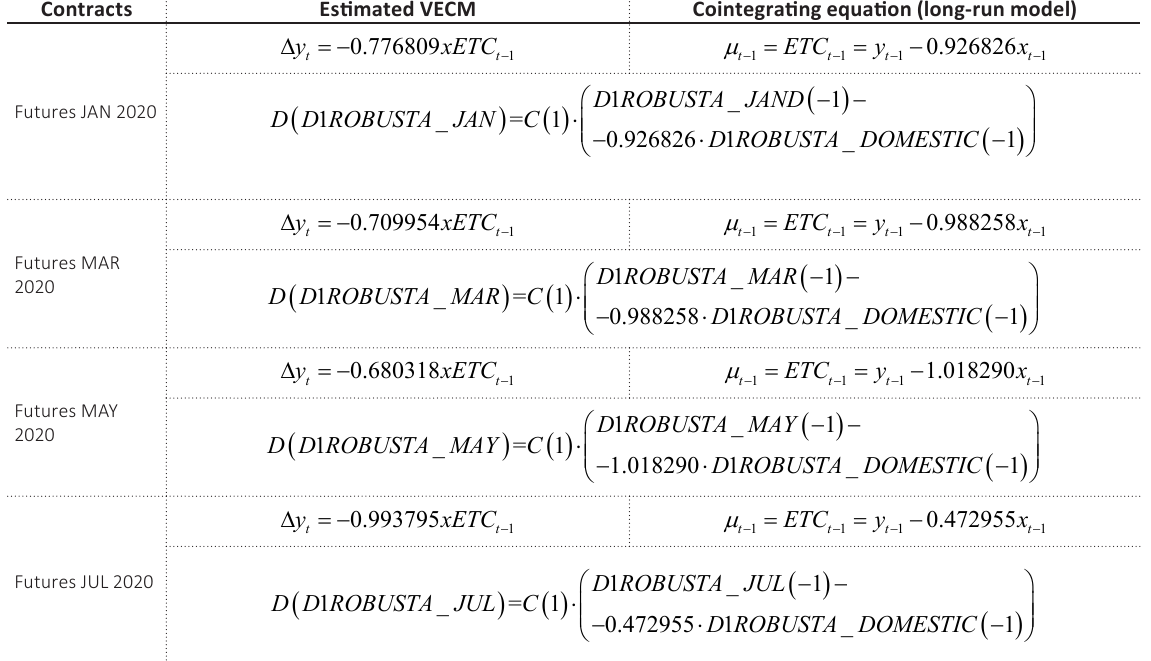
Table 6. Estimated VECM and cointegrating equation (long-run model) between Robusta spot prices and futures prices on ICE EU